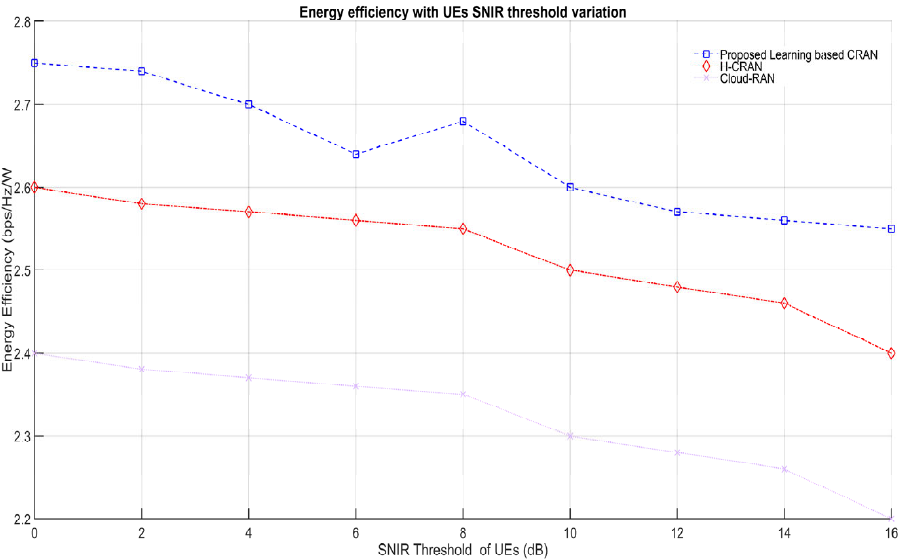
Figure 8. Energy efficiency with time variation on Enhanced C-RAN.